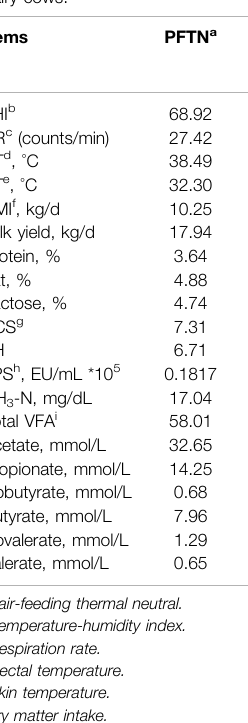
TABLE 2 | The vital signs, lactation performance and rumen fermentation of dairy